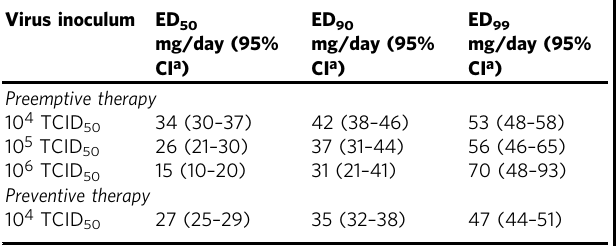
Dose – response curves are presented in Supplementary Fig. 3. a 95% con fi dence